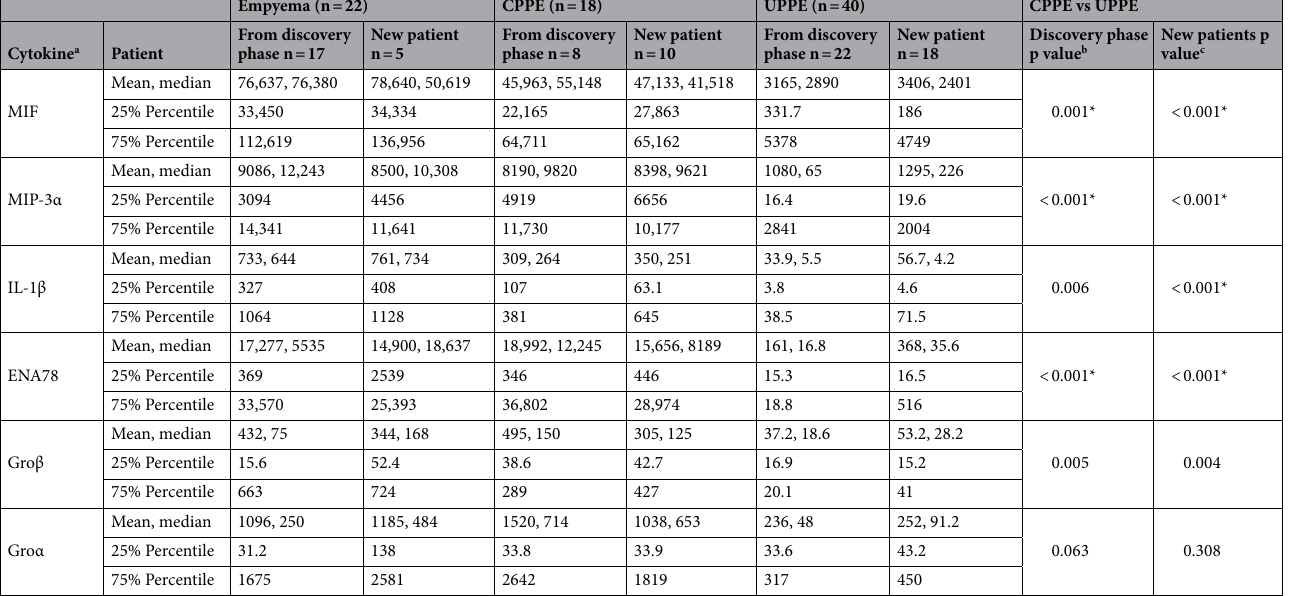
Table 3. The concentration of six cytokines in PPE patients using ELISA. a Data are presented as mean, median, and 25th–75th percentile (pg/ml). UPPE: uncomplicated parapneumonic effusion; CPPE: nonpurulent complicated parapneumonic effusion. Statistical analysis between CPPE and UPPE was